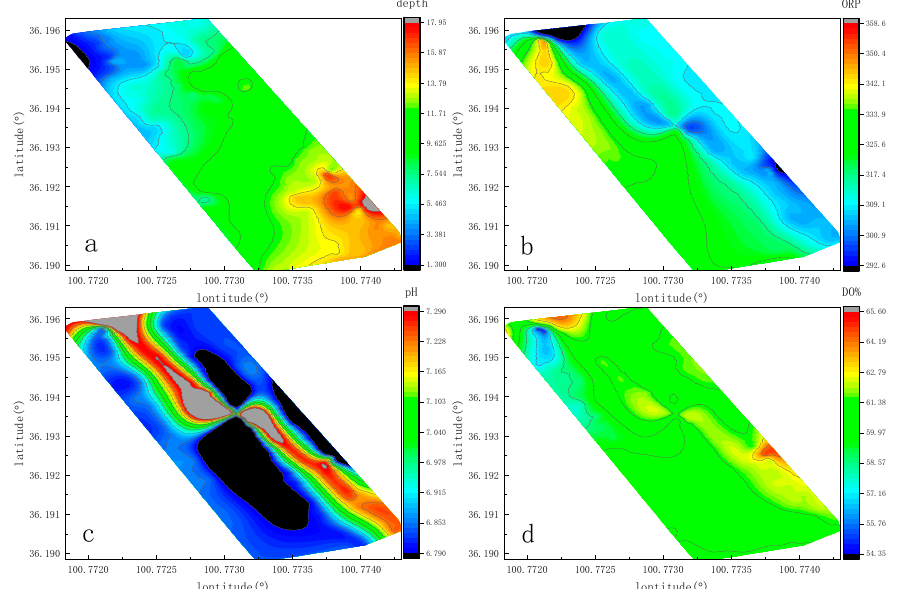
Figure 21. Partial hydrological results. ( a ): Depth of the detecting water; ( b ): Oxidation reduction potential distribution (ORP) of the detecting water; ( c ): pH value of the detecting water; ( d ): Dissolved oxygen (DO%) of the detecting water.